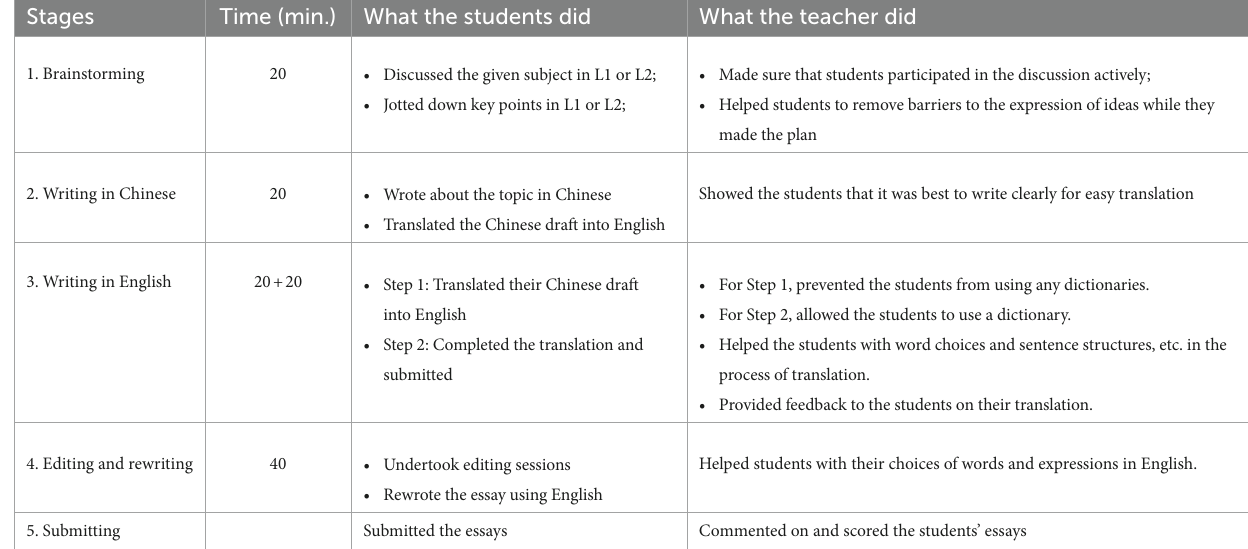
TABLE 2 The stages of the translation method in writing classes. Stages Time